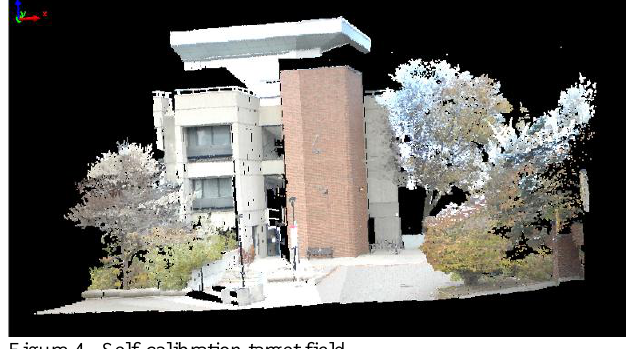
Figure 4. Self-calibration target